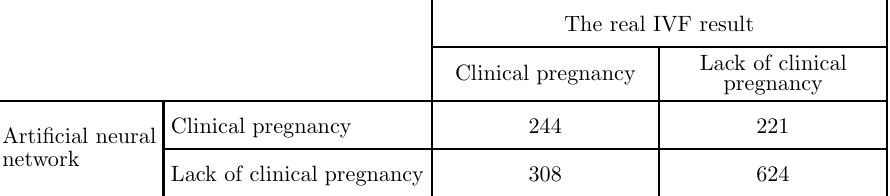
Table 4. The predictive effectiveness of the created neural network model